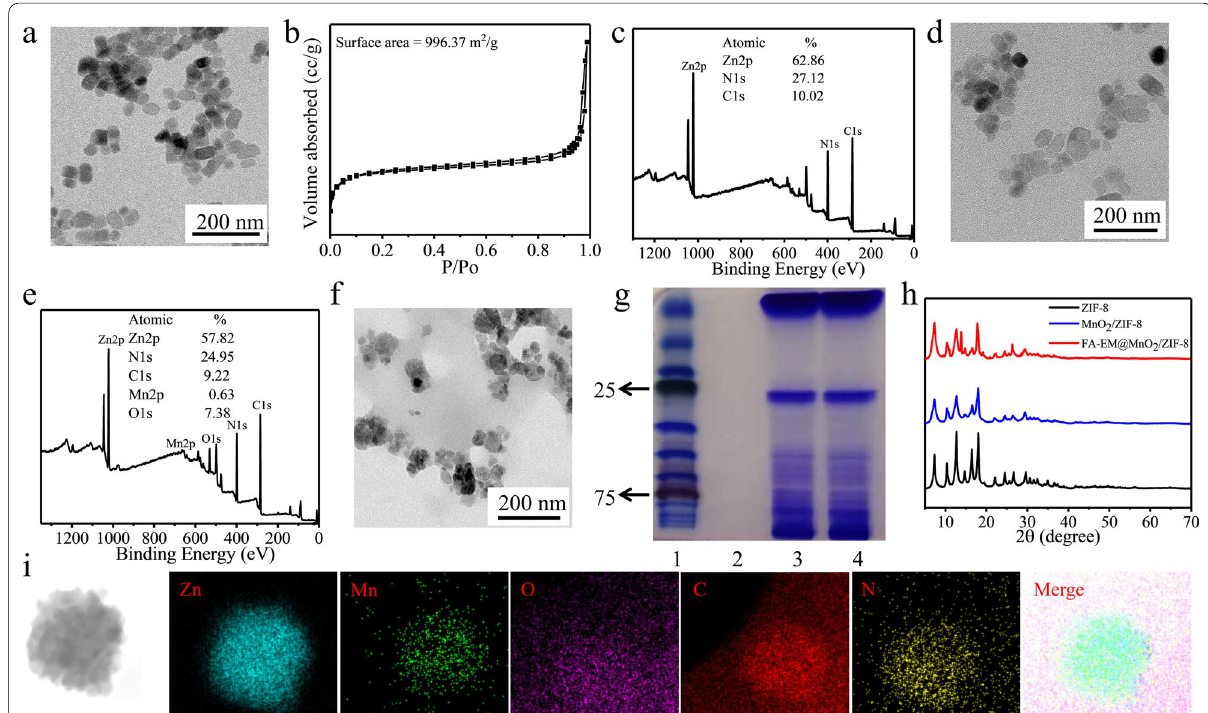
Fig. 1 Characterization of FA-EM@MnO 2 /ZIF-8 nano-platform. a TEM, b BET, and c XPS of ZIF-8 nano-platform. d TEM and e XPS of MnO 2 /ZIF-8 nano-platform. f TEM of FA-EM@MnO 2 /ZIF-8 nano-platform. g Protein analysis of protein marker (1), MnO 2 /ZIF-8 (2), EM (3), and FA-EM@MnO 2 /ZIF-8 (4) by using SDS–PAGE. Samples were stained with Coomassie Brilliant. h XRD spectra of ZIF-8, MnO 2 /ZIF-8, and FA-EM@MnO 2 /ZIF-8 nano-platform. i High-angle annular dark-field scanning TEM (HAADF-STEM) image and element mapping of FA-EM@MnO 2 /ZIF-8